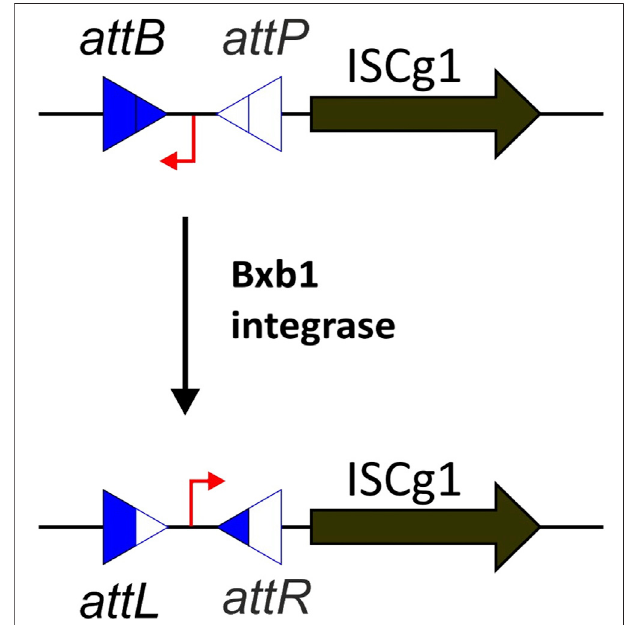
FIGURE 1 | Principle of the Bxb1 phage integrase genetic switch. In its default state, the promoter (in red) is in opposite orientation to the IS Cg1 transposase and therefore no expression takes place. As soon as the integraseisabundant,thebacterialandphageattachmentsites attB and attP are targeted by the integrase, transitioning the switch into the active state by recombination, forming the hybrid attachment sites attL and attR